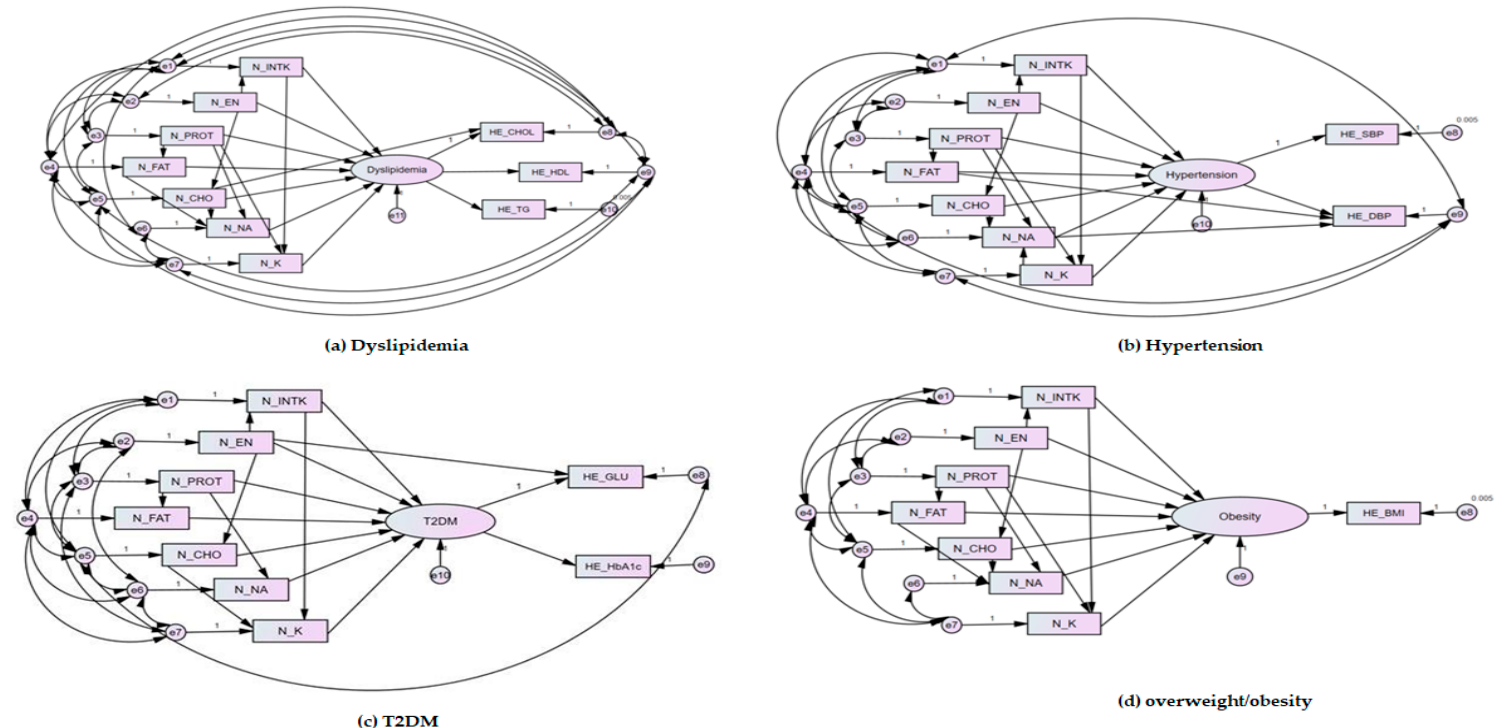
Figure 5. Path diagrams for structural equation models: ( a ) dyslipidemia to nutritional intake; ( b ) hypertension to nutritional intake; ( c ) T2DM to nutritional intake; ( d ) overweigh/obesity to nutritional intake. N_CHO, carbohydrate intake (g); N_EN, energy intake (kcal); N_FAT, fat intake (g); N_INTK, food intake (g); N_K, potassium intake (mg); N_NA, sodium intake (mg); N_PROT, protein intake (g); HE_BMI, overweight/obesity; HE_chol, total cholesterol; HE_dbp, diastolic blood pressure (mean value of 2–3 blood pressure measurements); HE_glu, fasting blood glucose; E_HbA1c, glycated hemoglobin; HE_HDL_st2, calibration of high-density lipoprotein cholesterol; HE_sbp, systolic blood pressure (mean value of 2–3 blood pressure measurements); HE_TG, triglyceride. Dyslipidemia, according to the Korean Society of Lipid and Atherosclerosis, dyslipidemia is defined as any one of the following: total cholesterol level ≥ 240 mg/dL, high-density lipoprotein cholesterol level < 40 mg/dL, triglyceride level ≥ 200 mg/dL, low-density lipoprotein cholesterol level ≥ 160 mg/dL, or the use of a lipid-lowering drug; hypertension, according to Korean hypertension, hypertension was defined when systolic blood pressure was ≥ 140 mmHg or diastolic blood pressure was ≥ 80 mmHg; Overweight/obesity, according to the Korean Society for the study of obesity; overweight/obesity defined when body mass index was 23 kg/m 2 or higher; T2DM, type 2 diabetes mellites according to the Korean Diabetes Association (KDA) T2DM was defined as fasting plasma glucose levels ≥ 126 mg/dL (7.0 mmol/L) or glycated hemoglobin ≥